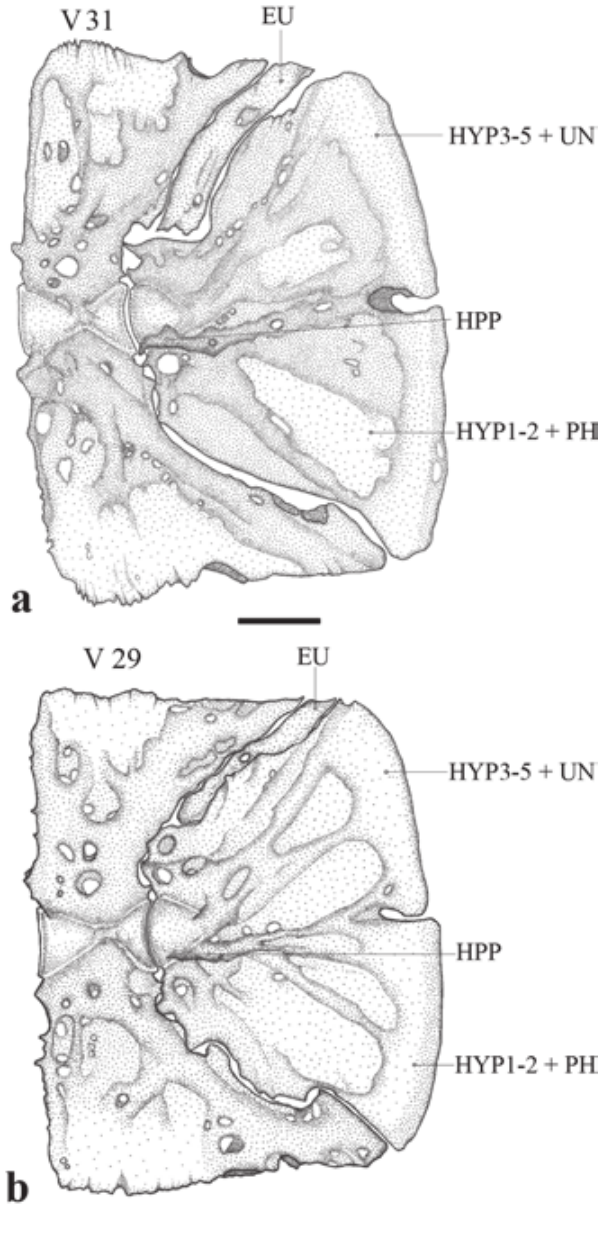
Fig. 3. Skeleton of the caudal fin, left side, lateral view. a - Pareiorhaphis azygolechis , MCP 21663, paratype, 68.9 mm SL; b - Pareiorhaphis ruschii MCP 44807, paratype, 61.8 mm SL. EU, Epural; HYP, Hypural; UN, Uroneural; HPP, Hypurapohysis; PH, Parypural; V, Vertebra. Scale bar = 2